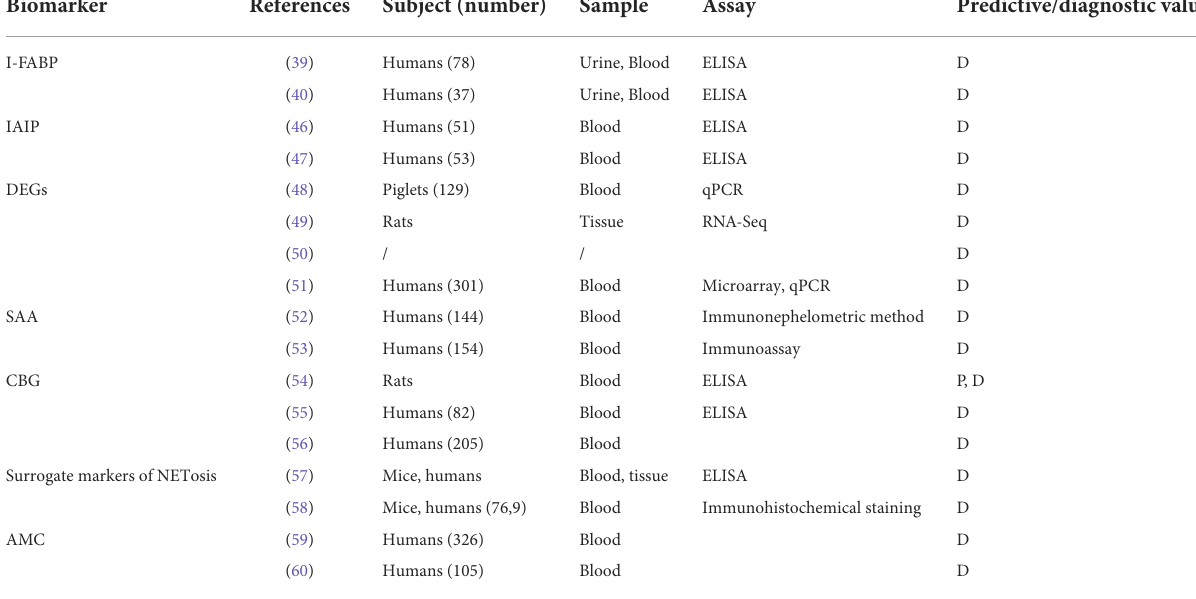
TABLE 3 Blood biomarkers of